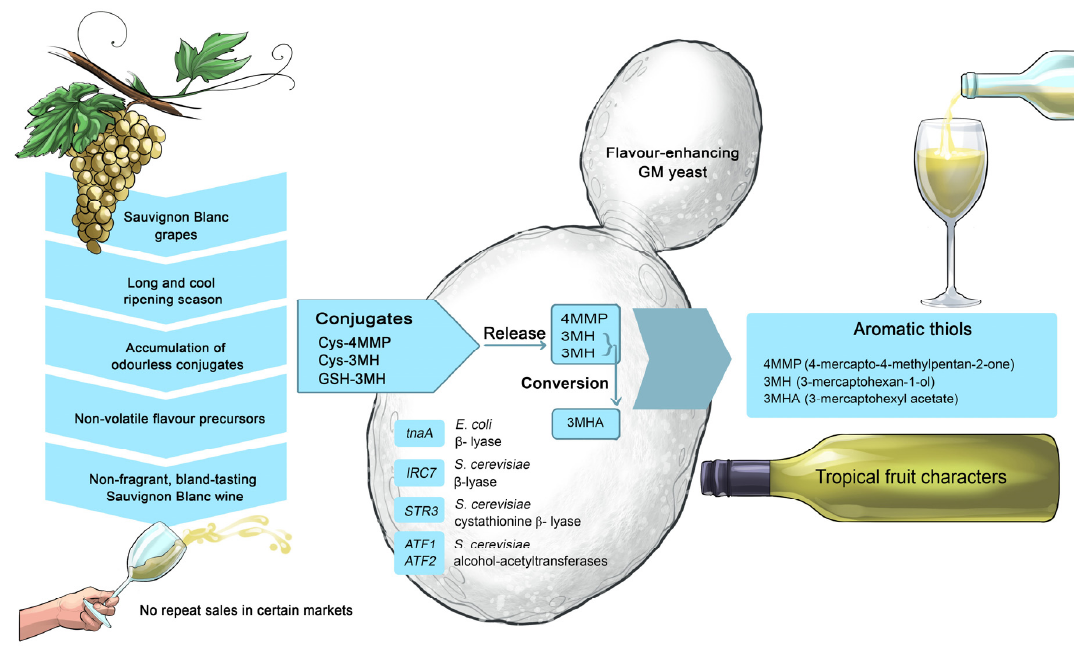
Figure 21. The construction of a wine strain of Saccharomyces cerevisiae that enhances the typical thiol ‐ driven aromas in Sauvignon Blanc and other wine types (adapted from